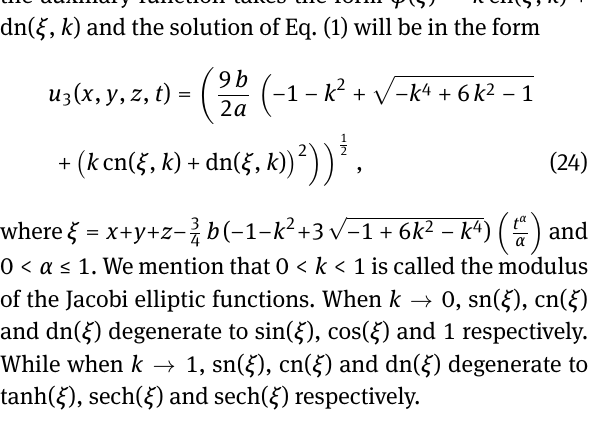
By substituting from (21) into Eq. (12) and by a